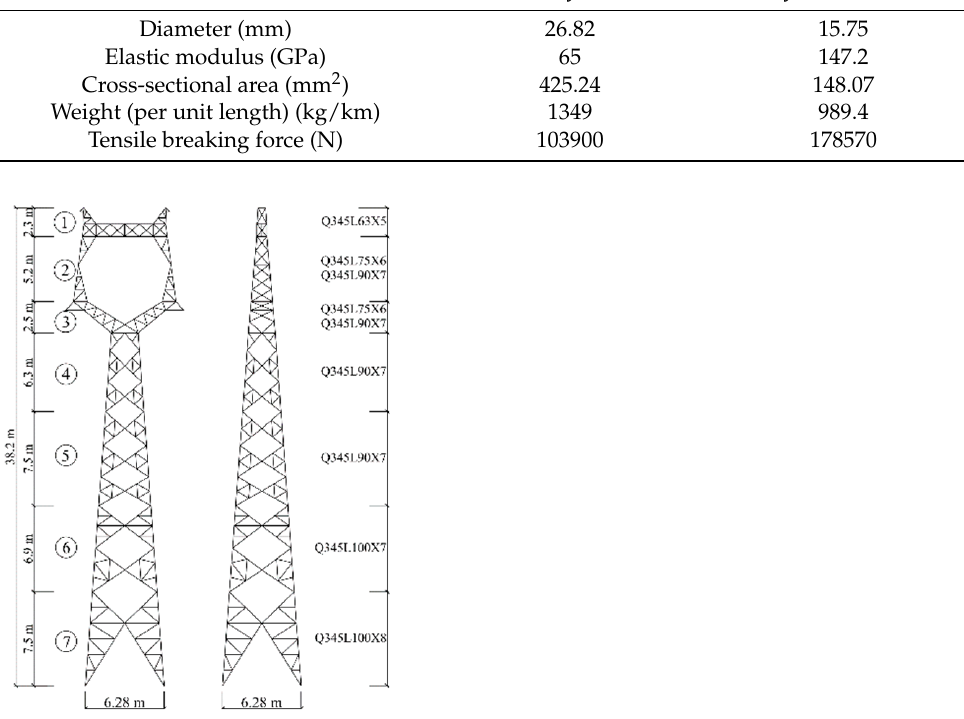
Figure 2. Segmentation of the tower and parameters of main leg members.